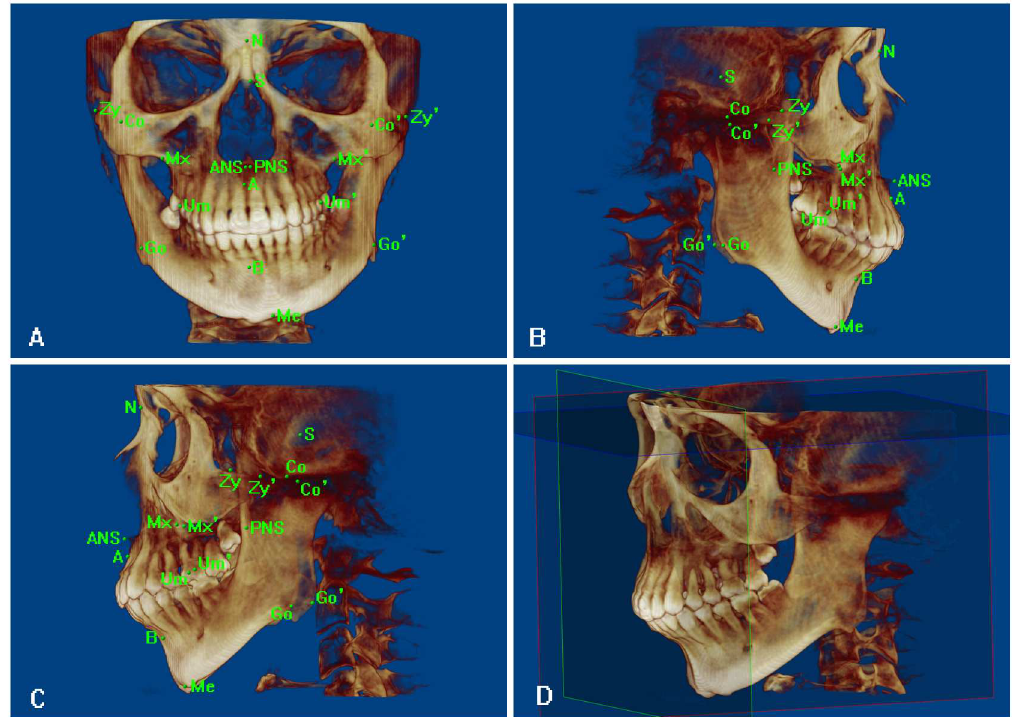
Fig 1. Maxillofacial hard tissue measurements. Relevantpoints and planes (ABC): N: the most concave and supremepoint of nasofrontal suture; S: the center point of the sella turcica; Zy: the most lateral and supremepoint of the zygomatic arch dividedinto Zy (i.e., the healthy side) and Zy’(i.e., the affected side); Co: the supreme point of the mandibularcondyledividedinto Co (i.e., the healthy side) and Co’ (i.e., the affected side); ANS: the point of the anterior nasal spine; Mx: the most interior and supreme point betweenthe infrazygomaand the maxillarymolar dividedinto Mx (i.e., the healthy side) and Mx’ (i.e., the affected side); PNS: the posterior-most point of the hard palate; A: the most concave point betweenthe anterior nasal spine and the upper alveolarmargin sagittally; Um: the most lateral point of first upper molar dividedinto Um (i.e., the healthy side) and Um’(i.e., the affected side); B: the most concave point of the anterior alveolarbone aroundlower incisors sagittally; Go: the posterior-most and nethermost point of the mandibular angle dividedinto Go (i.e., the healthy side) and Go’(i.e., the affected side); Me: the gnathion;Occ: the occlusal plane passingthe two centers of the bilateralfirst upper molar overbite and the center of the central incisors overbite; MP: the plane passingMe, Go and Go’. Coordinate system (D):X: The horizontal plane crossing the straight line that rotated aroundN 7 degreesupwardalong NS and paralleledthe two innermost points of the zygomaticofrontal suture on both sides; Y: The sagittal plane crossing N and the center point of the crista galli and perpendicular to X; Z: The coronal plane crossing N and perpendicular to X and Y. Fourteen integral items: SNA angle; SNB angle; ANB angle; Occ/X: the minor angle betweenOcc and X; MP/X: the minor angle betweenMP and X; ANS-PNS: the distancebetweenANS and PNS; N-Me(Y): the distancebetweenN and the point that was projectedby Me vertically on Z; N-ANS(Y): the distancebetweenN and the point that was projected by ANS vertically on Z; ANS-Me(Y): the distancebetweentwo points that were projectedby ANS and Me vertically on Z; Zy-Zy’/Y: the lower angle on tonic side betweenthe line crossing Zy and Zy’ and Y; Mx-Mx’/Y: the lower angle on the tonic side betweenthe line crossing Mx and Mx’ and Y; Go-Go’/Y: the lower angle on the tonic side betweenthe line crossing Go and Go’ and Y; Occ/Y: the lower angle on tonic side betweenOcc and Y; Me(X): the vertical distance betweenMe and Y. Twelve asymmetrical items: Co-Me: the distancebetween Co and Me dividedinto Co-Me and Co’-Me; Go-Me: the distancebetweenGo and Me dividedinto Go-Me and Go’-Me; Co-Go: the distancebetweenCo and Go divided into Co-Go and Co’-Go’; Go-Me(Y): the distancebetweenthe two points that were projectedby Go and Me vertically on Y and dividedinto Go-Me(Y) and Go’-Me(Y); Go(X): the vertical distancebetweenGo and Y dividedinto Go(X) and Go’(X); Go(Y): the vertical distancebetweenGo and X dividedinto Go(Y) and Go’(Y); Go(Z): the vertical distance betweenGo and Z dividedinto Go(Z) and Go’(Z); Co(X): the vertical distancebetweenCo and Y dividedinto Co(X) and Co’(X); Co(Y): the vertical distancebetweenCo and X dividedinto Co(Y) and Co’(Y); Co(Z): the vertical distance betweenCo and Z dividedinto Co(Z) and Co’(Z); Co-Go-Me: the angle consisting of Co, Go and Me dividedinto Co- Go-Me and Co’-Go’-Me; Um-Mx(Y): the distancebetweentwo points that were projected by Um and Mx vertically on Y and dividedinto Um-Mx(Y) and Um’-Mx’(Y).